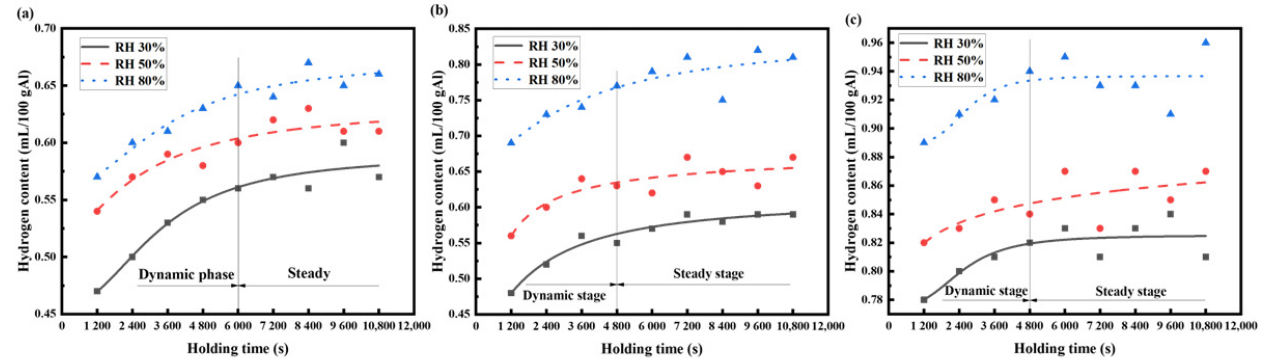
Figure 3. Variation in hydrogen content in AA6111 alloy melt at the same temperature and different humidity: ( a ) 973 K, ( b ) 1023 K, ( c ) 1073 K.